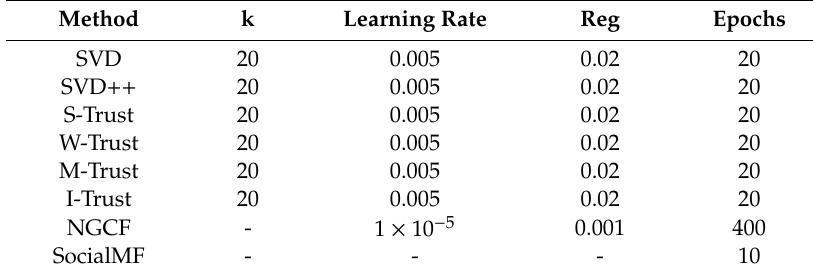
Table 1. Model parameters for the experimental methods. I-Trust: Initial trust, M-Trust: mean-trust concatenation, NGCF: Neural graph collaborative filtering, S-trust: Subtract-trust, SocialMF: Social matrix factorization, SVD: Singular value decomposition, SVD ++ : An extension of SVD that considers the implicit feedback, W-Trust: